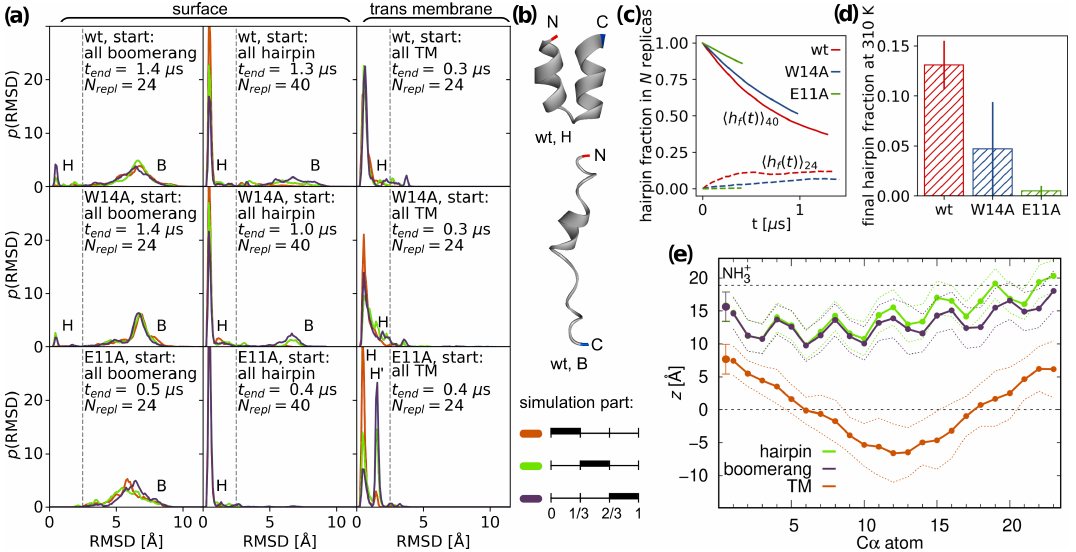
Figure 1. ( a ) Time evolution for distributions of backbone atoms RMSD with respect to tight helical hairpin (NMR structure, PDB id 2kxa, model 1) at 310 K from tREMD simulations. ( b ) Representative conformations for two most populated states. ( c ) Time evolution of hairpin fraction in tREMD simulations based on fitted kinetic equations. ( d ) Equilibrium hairpin fractions at 310 K. ( e ) Insertion depths of N-terminal amino group nitrogen and C α atoms of wt HAfp ± one standard deviation (dotted lines). Dashed lines are the membrane surface (the maximum of phosphate atoms